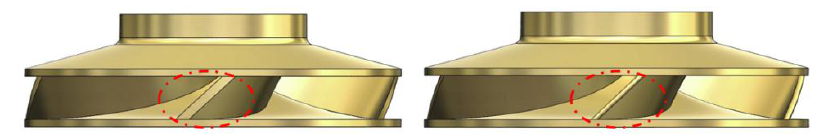
Figure 2. Physical picture of rounded blades.